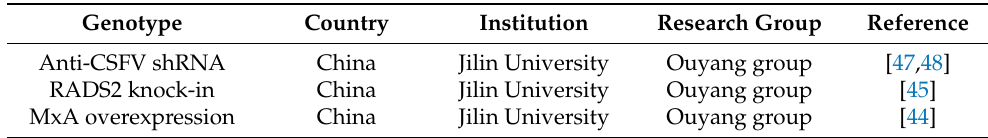
Table 2. Advance of genetically modified pigs resistant to CSFV infection.